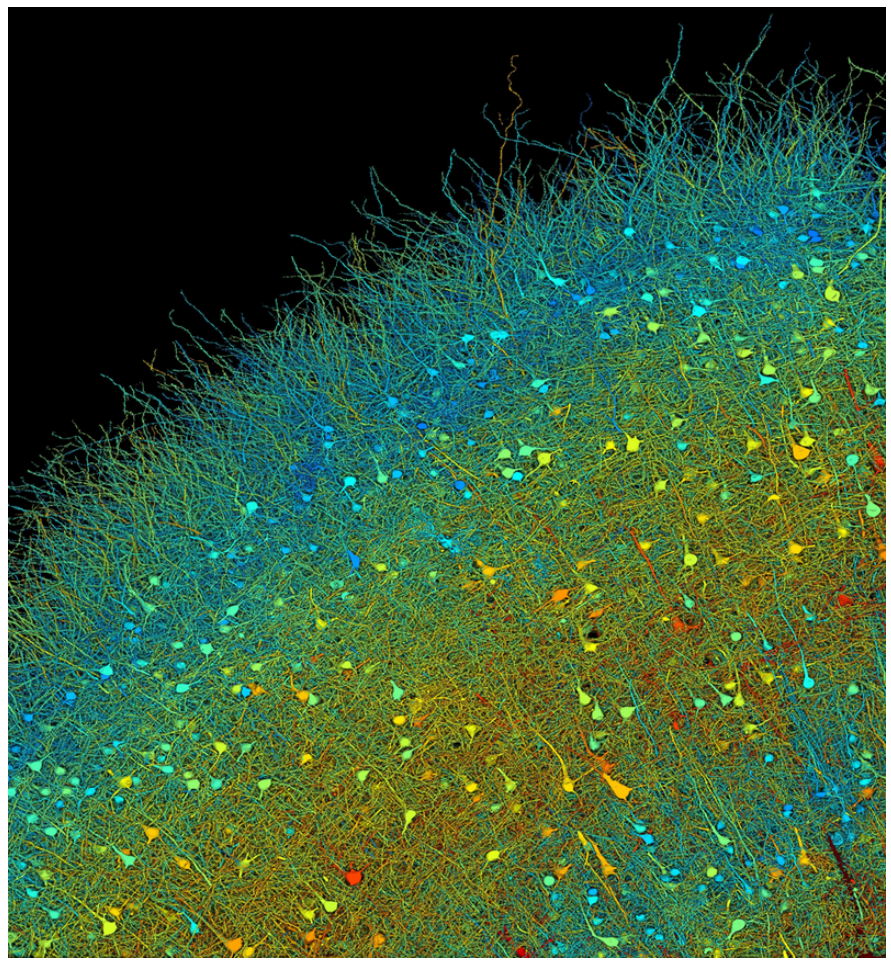
Figure 2. Dense 3D neuron reconstruction at the nanometer scale from one cubic millimeter of a human cerebral cortex (zoomed-in view). Generating and confirming hypotheses in this 1.4-petabyte dataset is challenging (Shapson-Coe et al., 2021). Data available at Explore | H01 Release